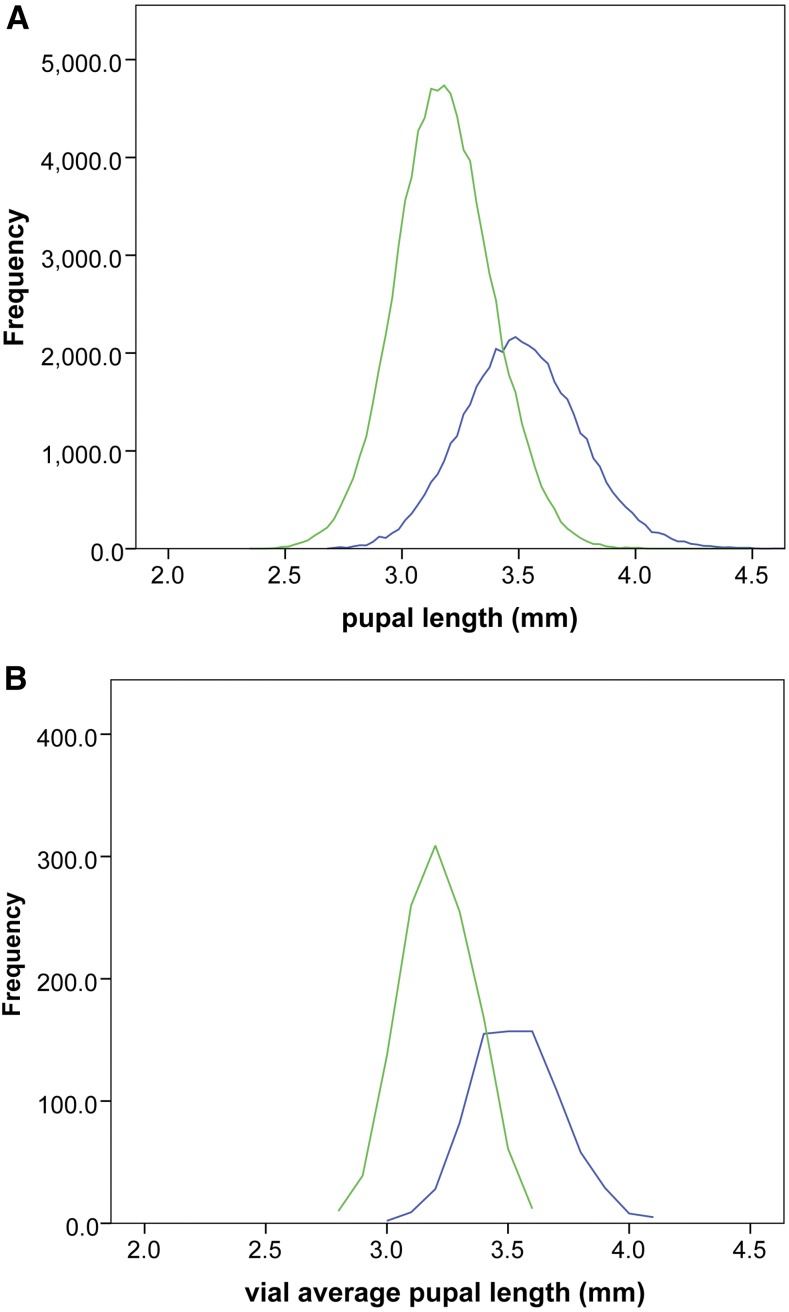
Sampling distributions of pupal length for individuals and vials. (A) Distributions for individual pupal lengths: four-way dataset (blue) n = 47,843 and eight-way dataset (green) n = 86,515. (B) Corresponding distributions for vial mean pupal lengths: four-way dataset (blue) n = 799 vials and eight-way dataset (green) n = 1251 vials. Only vials where ≥15 pupae were measured by the automated system are considered. A stock possessing the Tb1 mutation, resulting in the well-known tubby pupal phenotype (Bloomington stock 3644), was measured and found to have a mean pupal length of 2.7 mm, which is at the lower bounds of the smallest wildtype individuals or vials shown here.